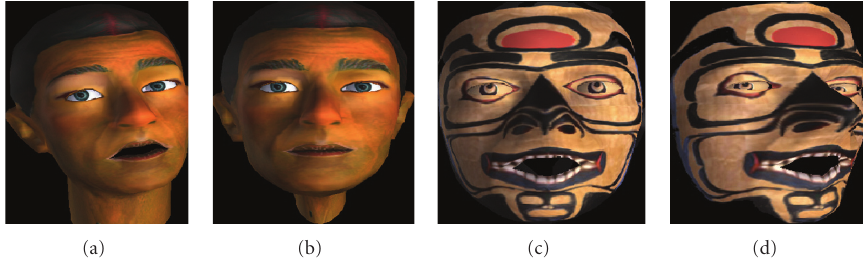
Figure 8: Screen shots of real-time interactive animation layering additive voice, expression-unit and facial unit layers.